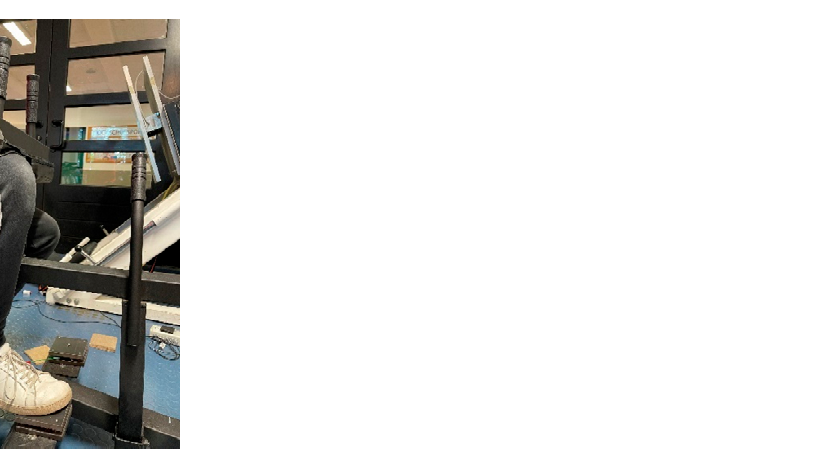
Figure 1. Calf-muscle-testing device (CMD) measuring the maximum isometric strength in pre- and post-test with force plates.